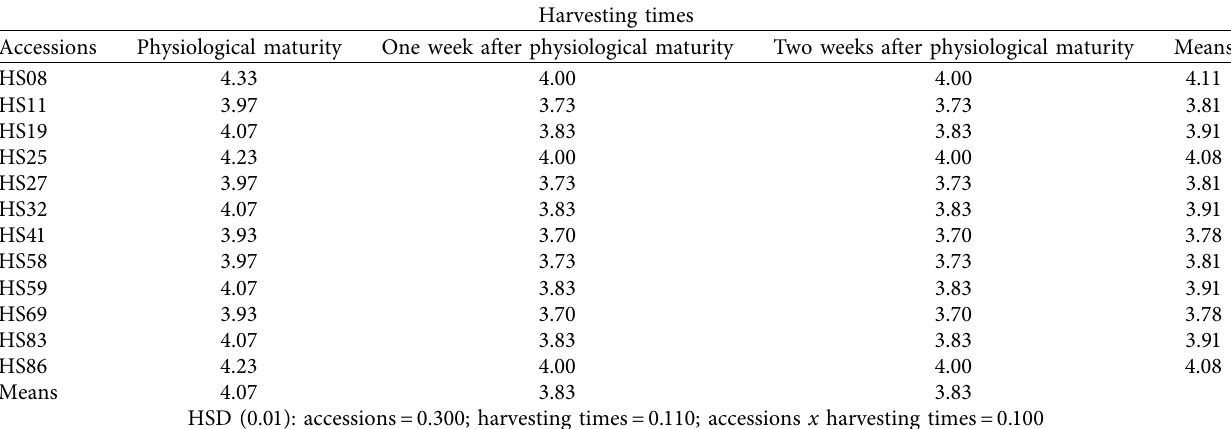
Table 2: Interactive effects of harvesting times x accessions on the seed length (mm) of